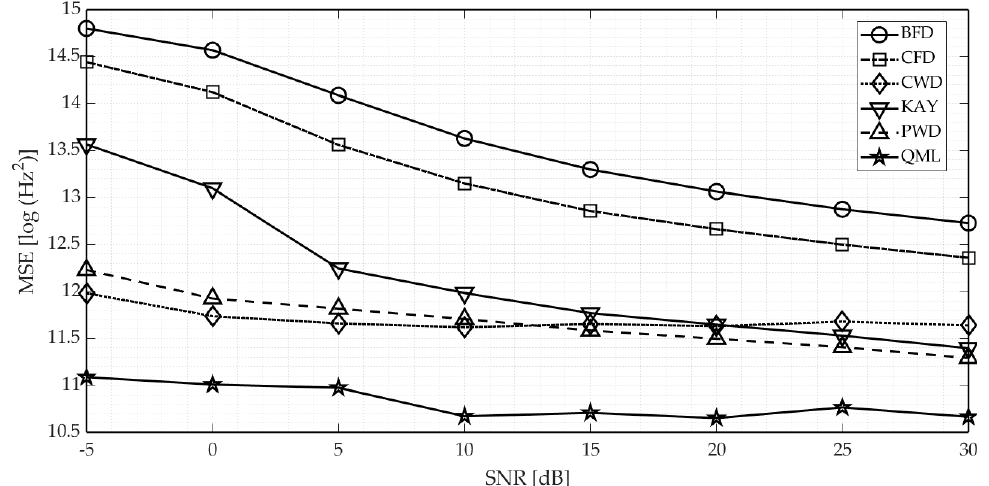
Figure 6. Comparison of estimators’ accuracy in terms of the mean squared error (MSE) for the NLFM A waveform.